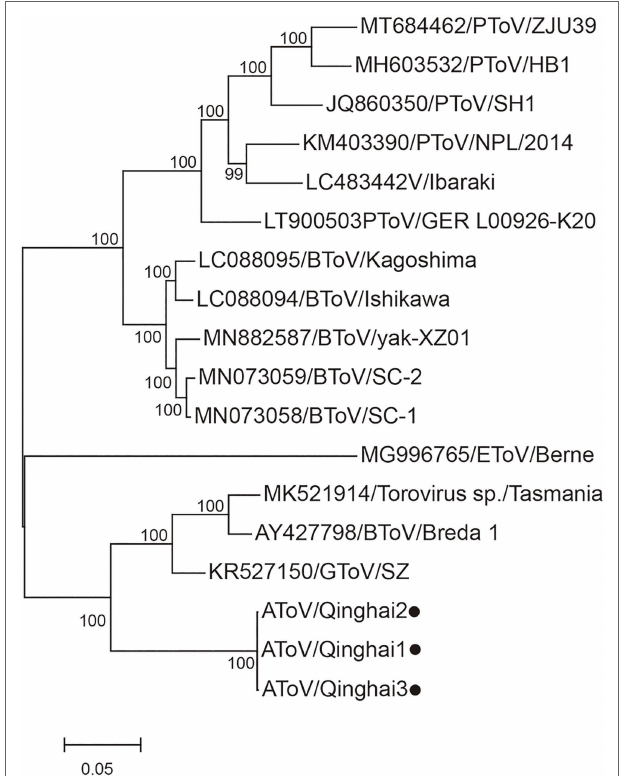
FIGURE 5 | Phylogenetic analysis of the complete genomic nucleotide sequence of all ToVs. Strains of AToV were marked with black circles. The tree was constructed using MEGA 7.0 by the maximum likelihood method (1,000 bootstrap replications). Bootstrap values (>70%) are shown at the branches. The scale bar below indicates the nucleotide substitutions per